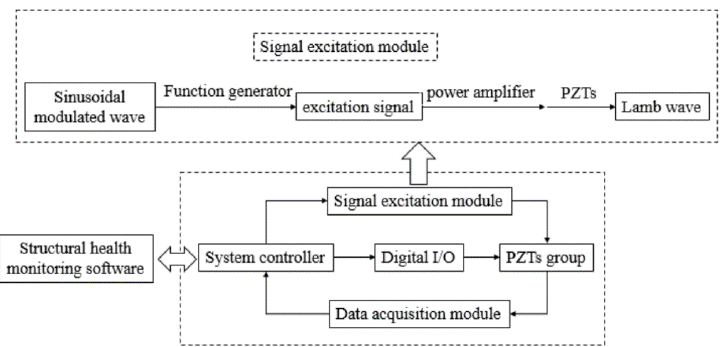
Figure 2. Transmission process of the monitoring signal.